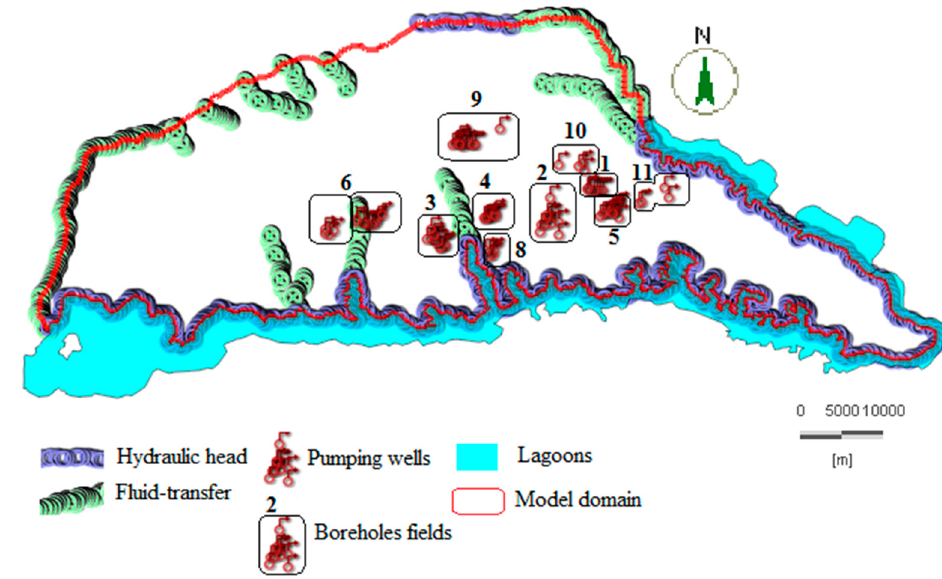
Figure 6. Boundary conditions of the model. Hydraulic heads (58 m for the north, and 0.2 m for the south). Fluid transfer boundaries ranging from 0 m to 57 m according to the elevation. Borehole fields: 1 (Riviera Center), 2 (Zone Est), 3 (Zone Ouest), 4 (Zone Nord), 5 (Nord Riviera), 6 (Niangon), 8 (Adjamé Nord), 9 (Anoukoua Kouté), 10 (Djibi), and 11 (Abatar-Akandje). Constant hydraulic head boundary conditions of 58 m (mean piezometric level) and 0.2 m